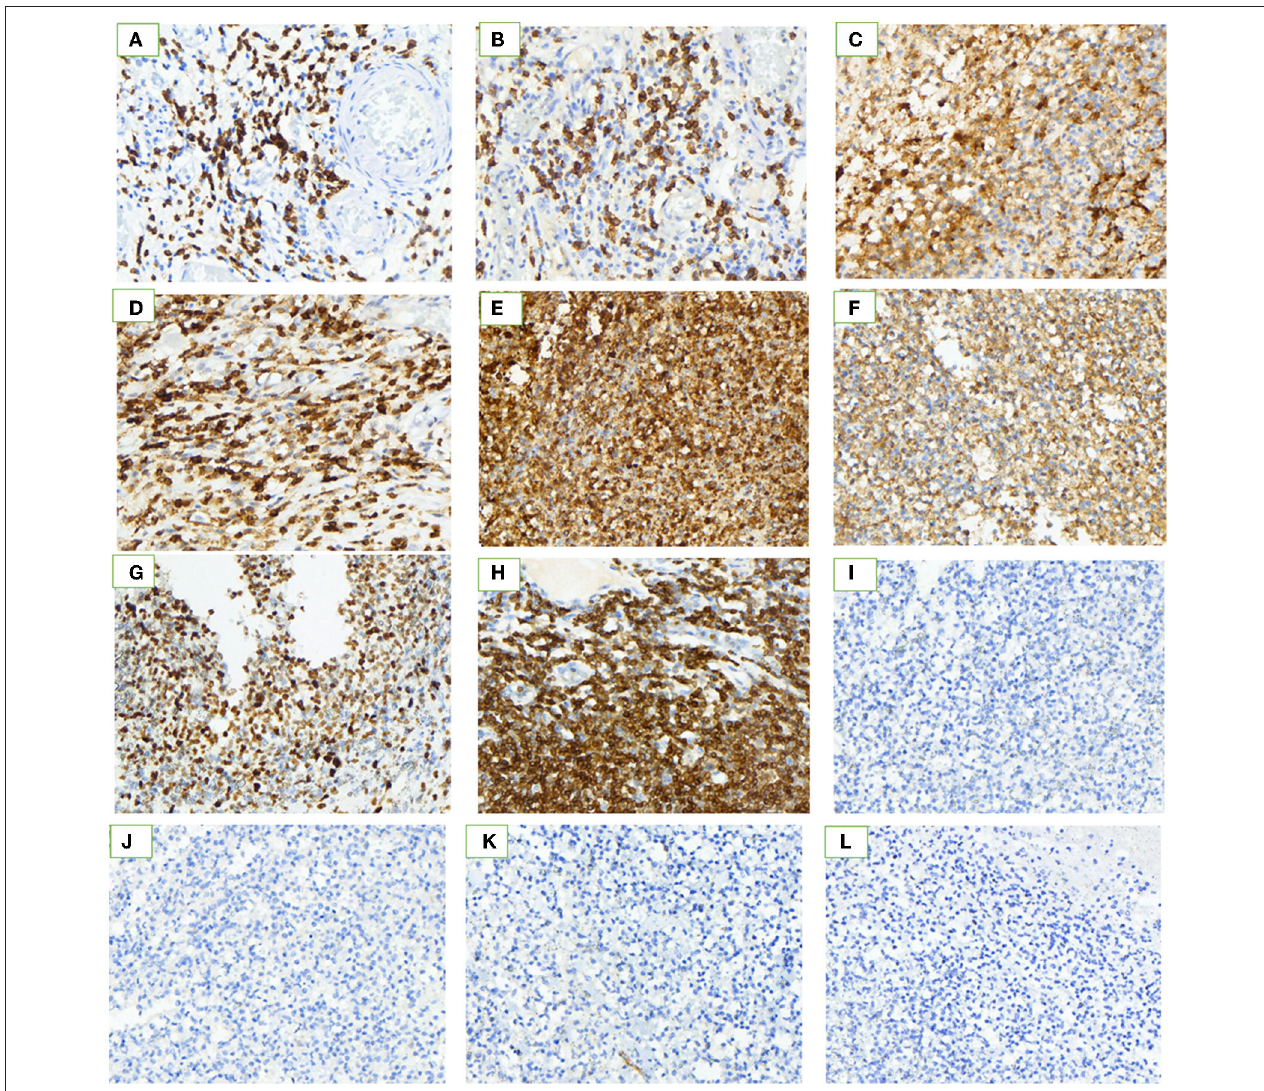
FIGURE 3 | Immunohistochemistry. Histopathological examination showed hematoxylin and eosin stains (H&E × 40). The neoplastic lymphocytes are small-to-medium-size with dark staining nuclei, conspicuous nucleoli, and scarce cytoplasm, and have infiltrated all the layers of the jejunal wall. The immunohistochemical characteristics of tumor cells. (A–I) Immunohistochemical stain is strongly positive for the neoplastic cells. (J–L) Immunohistochemical stain is negative. Positive: (A) CD3; (B) CD5; (C) CD10; (D) CD45R0; (E) CD15; (F) TIA-1; (G) Ki-67 (40%); (H) Bcl-2; and (I) CD138. Negative: (J) Cyclin D1; (K) CD56; (L)